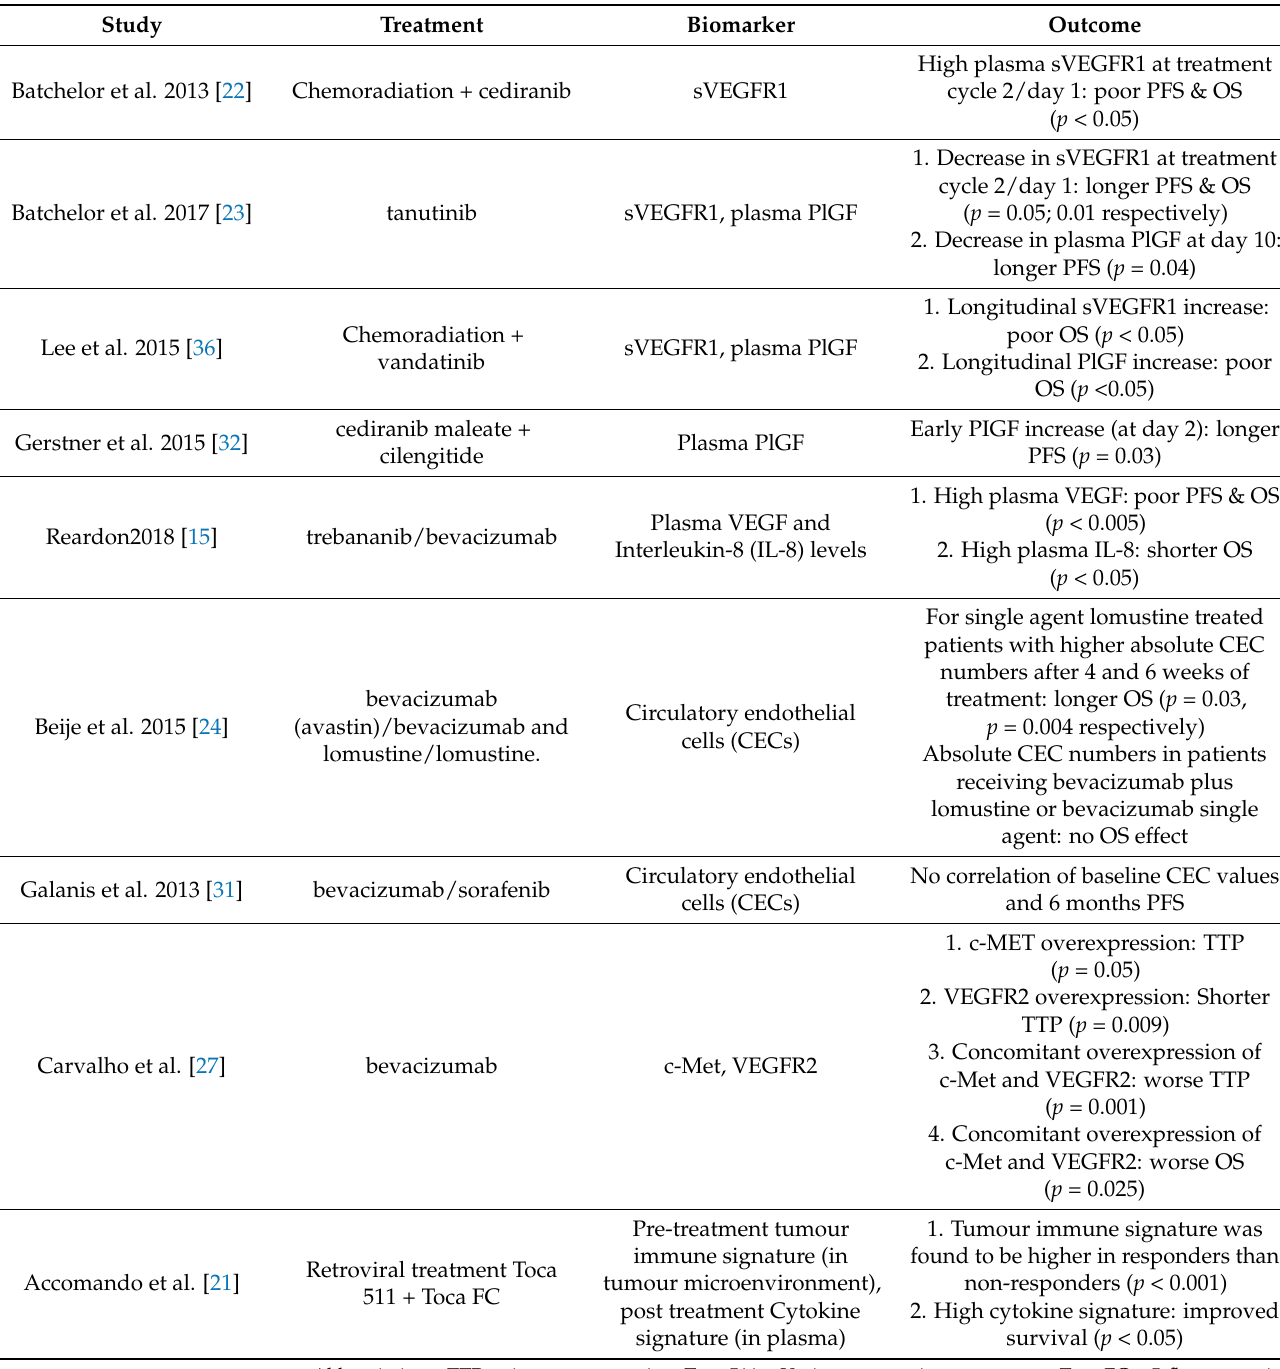
Table 3. The association of other biomarkers with treatment response in GBM